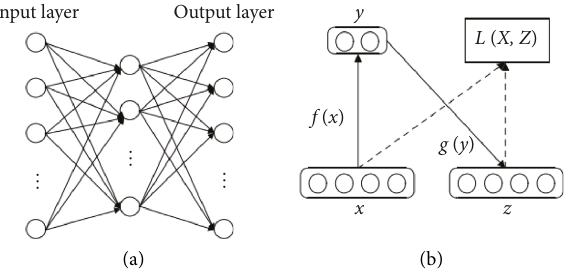
Figure 3: Autoencoder structure and principle diagram. (a) AE basic structure, (b) AE fundamentals.